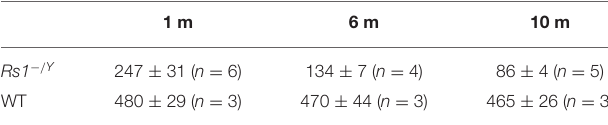
TABLE 2 | a’ wave of different age groups (0 log cd.s/m 2